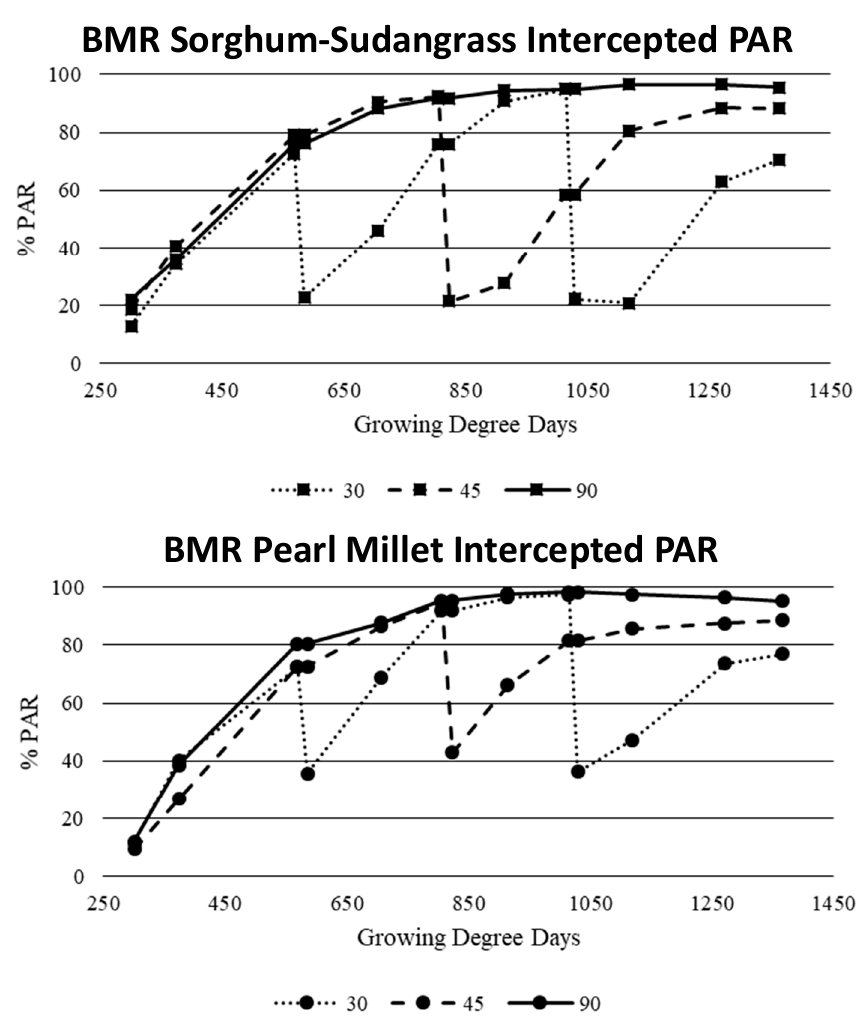
Figure 5. Brown midrib (BMR) sorghum-sudangrass and BMR pearl millet intercepted photosynthetically active radiation (PAR) for three different harvest intervals three 30-d, two 45-d, and one 90-d) in 2017 at Canyon, TX, USA.